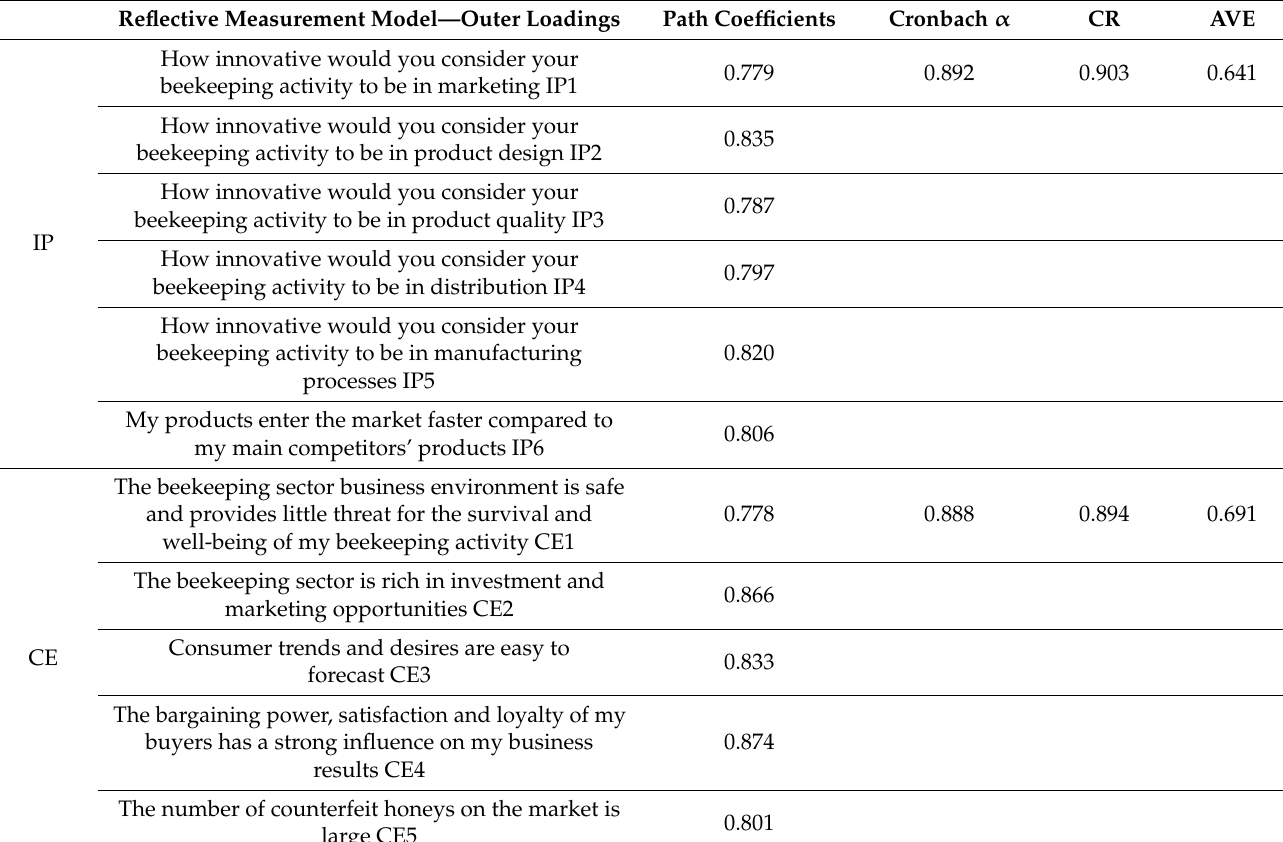
Table 3. Presentation of values of standardized factor loads and results of the reflective measure- ment